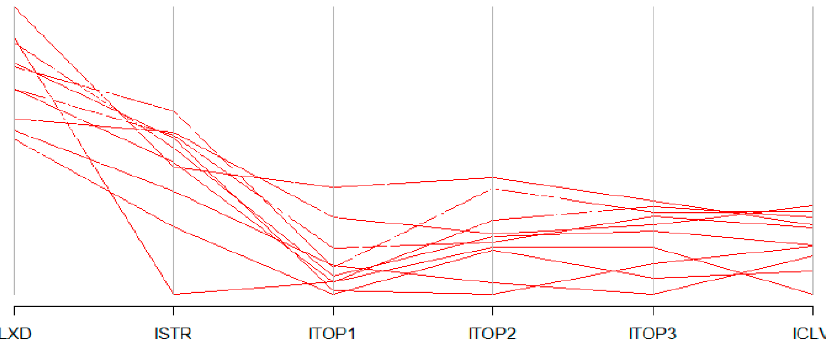
Figure 3. Parallel coordinates graphs for the estimations of latent variables in the model in Figure 2. This plot was obtained with R package MASSGGally: ggparcoord.